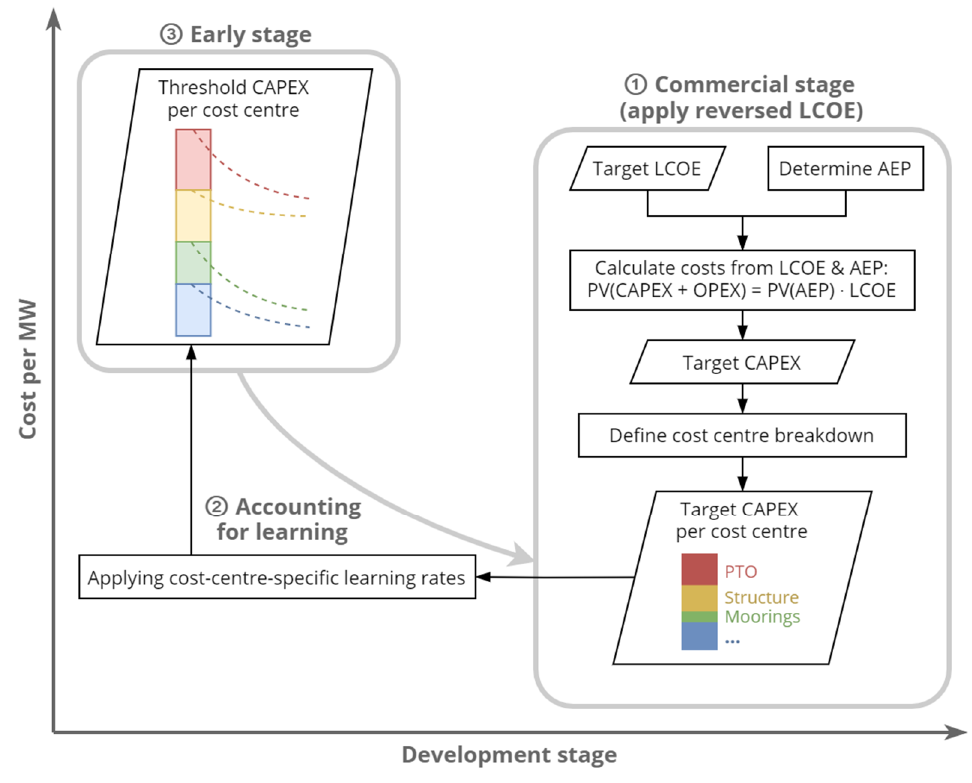
Figure 1. Overview of the methodology.